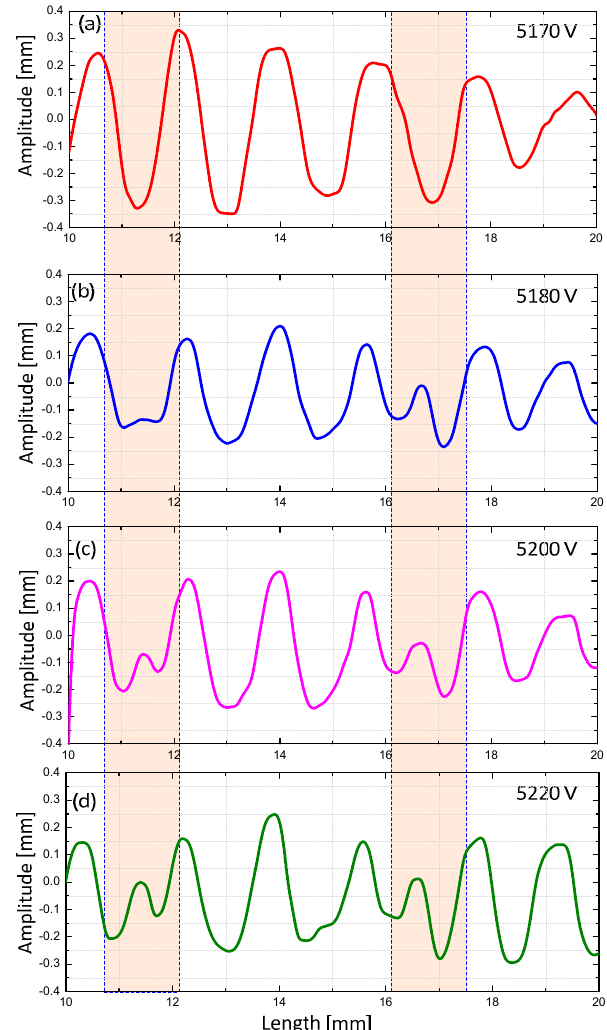
Figure 11. Local growth of a small wrinkle with the voltage at ( a ) 5170 V ( b ) 5180 V ( c ) 5200 V ( d ) 5220 V.